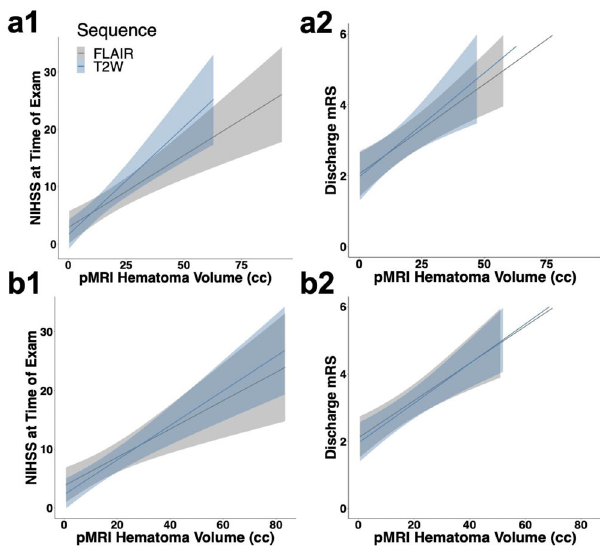
Fig. 5 Hematoma volume and cognitive scores on portable MRI. Manual pMRI hematoma volume versus ( a 1) cognitive status (NIHSS) at time of exam (pMRI T2W ( n = 33): ρ = 0.750, 95% CI: [0.591 – 0.906], p = 4.95e- 7; pMRI FLAIR ( n = 34): ρ = 0.802, 95% CI: [0.669 – 0.930], p = 1.23e-8) and a 2 functional status (mRS) at discharge (pMRI T2W ( n = 36): ρ = 0.589, 95% CI: [0.372 – 0.804], p = 1.55e-4; pMRI FLAIR ( n = 37): ρ = 0.641, 95% CI: [0.425 – 0.855], p = 1.89e-5). Averaged ABC/2 estimated pMRI hematoma volume versus ( b 1) cognitive status (NIHSS) at time of exam (pMRI T2W ( n = 36): ρ = 0.805, 95% CI: [0.659 – 0.948], p = 3.18e-9; pMRI FLAIR ( n = 34): ρ = 0.776, 95% CI: [0.617 – 0.930], p = 7.16e-8) and (b2) functional status (mRS) at discharge (pMRI T2W ( n = 39): ρ = 0.747, 95% CI: [0.592 – 0.899], p = 4.85e-8; pMRI FLAIR ( n = 37): ρ = 0.669, 95% CI: [0.483 – 0.853], p = 5.98e-6). Spearman correlations are reported for a 1, a 2, b 1, and b 2 with con fi dence intervals. Bands represent 95% con fi dence